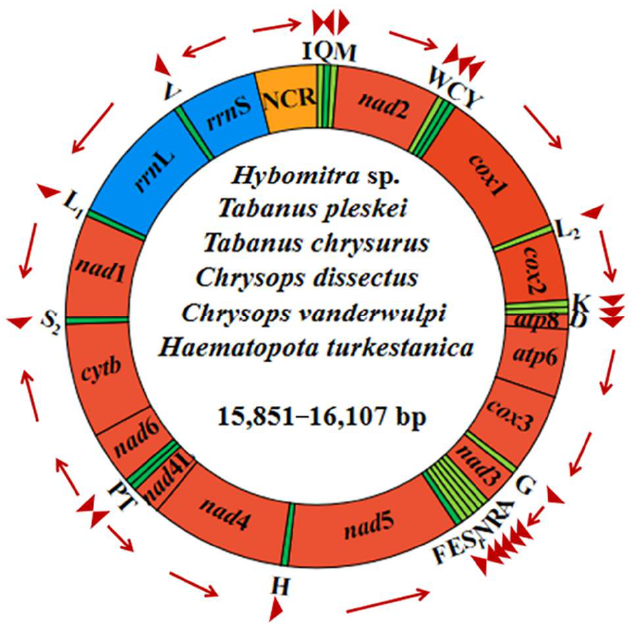
Figure 3. Structural representations of the six newly sequenced horseflies mitogenomes. The circle represents the arrangement of PCGs, tRNAs, and rRNAs. Each tRNA is identified by a unique letter abbreviation. ‘NCR’ indicates the non-coding region.